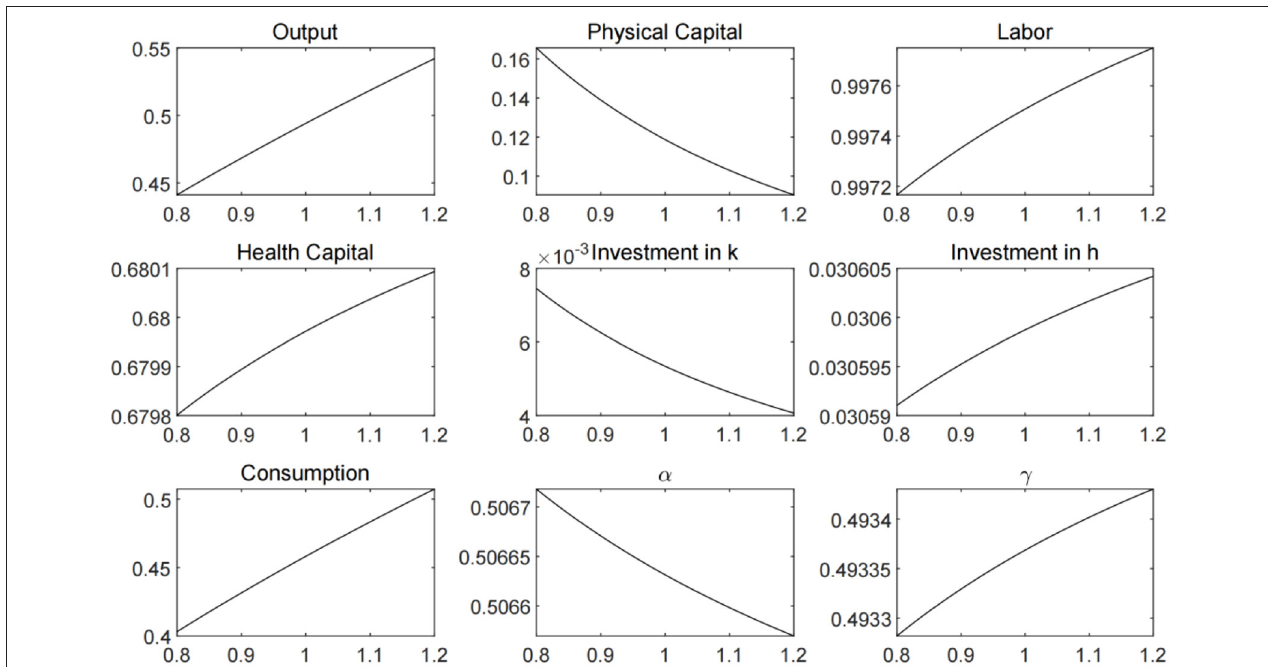
FIGURE 6 | Economic steady state under different productivity levels.